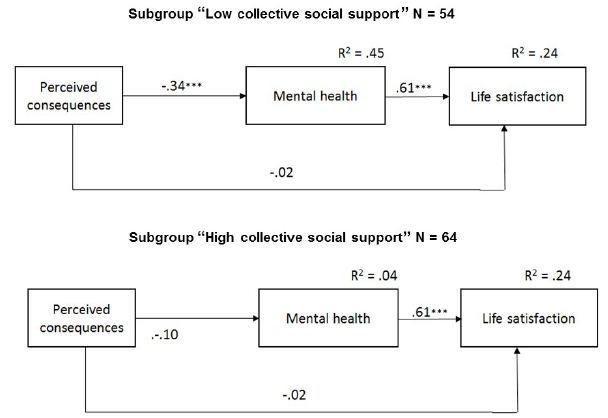
Figure 4. Results of the multiple group analysis. Note: unstandard- ized path coefficients; R 2 = explained variance; ∗∗∗ = p < 0 . 001, ∗∗ p < 0 . 01; interpersonal support omitted (not